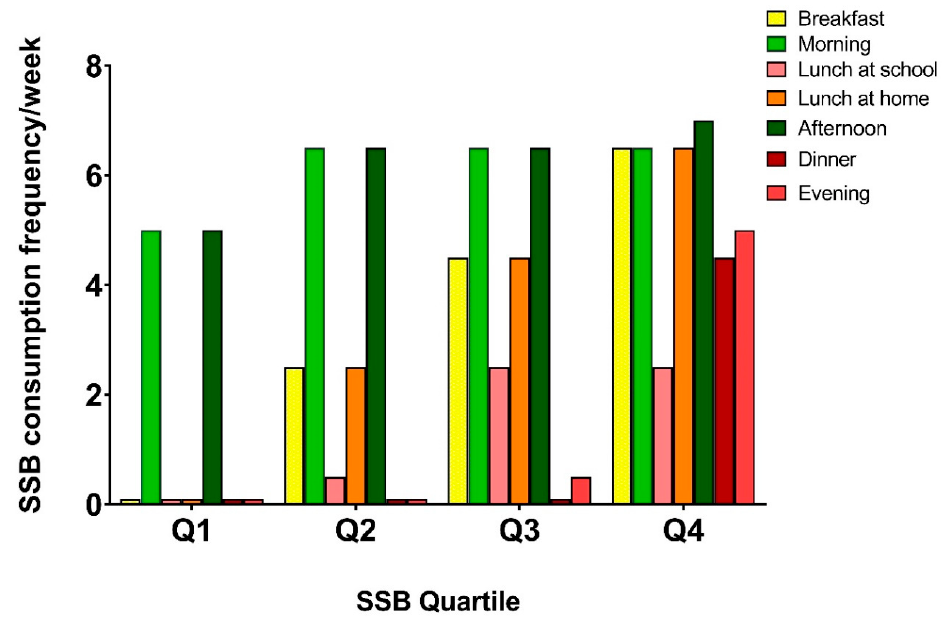
Figure 1. Median SSB consumption frequencies at various time segments show different trends over the quartiles of total SSB intake. The median of total SSB consumption frequency for children in Q1 is 13, in Q2 is 19, in Q3 is 25.5, and in Q4 is 34 per week. For all time segments, consumption frequency was higher in the higher quartiles ( p <